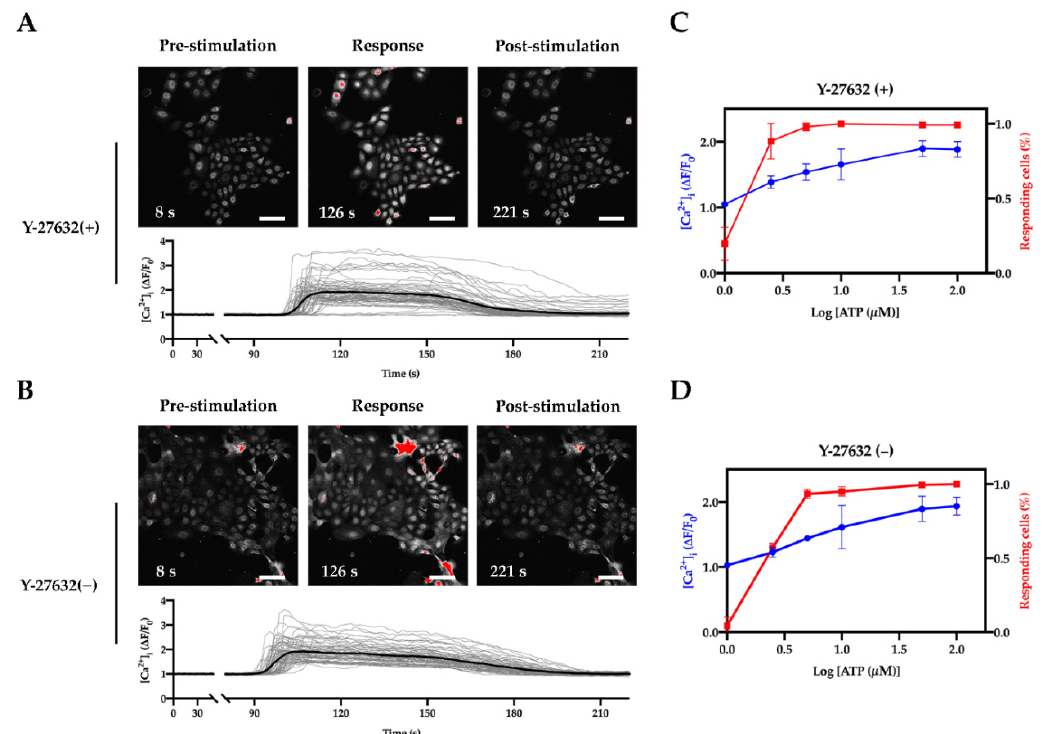
Figure 4. ATP-induced calcium responses in RLKs. ( A , B ) Representative images and traces showing the changes of cytosolic Ca 2+ in responses to 50 µ M ATP in RLKs treated with Y-27632 ( A ) or without Y-27632 for 1 day ( B ). Individual cells are stained with Fluo-4 and pseudo-colored in white. Red areas indicate cells that have a very high intracellular calcium level to the extent that oversaturation occurs. The gray traces represent the response profiles of individual cells and the black traces represent the average of the responses. Scale bar, 100 µ m. Note: The difference in the start time of responses of the cells in panels ( A , B ) was due to exogenous inter-sample variances caused by the experimental setup and handling. ( C , D ) Dose-dependent responses of RLKs to ATP at different concentrations (1 µ M, 2.5 µ M, 5 µ M, 10 µ M, 50 µ M, and 100 µ M) in the presence (C; n = 3 coverslips; total no. of cells analyzed = 247) and absence (D; n = 3 coverslips; total no. of cells analyzed = 226) of Y-27632 for 1 day. The cells analyzed were at passage